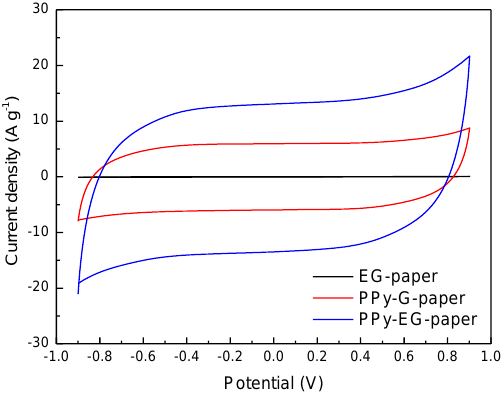
Figure 5. CV curves of EG-paper, PPy-G-paper, and PPy-EG-paper at a scan rate of 5 mV ∙ s − 1